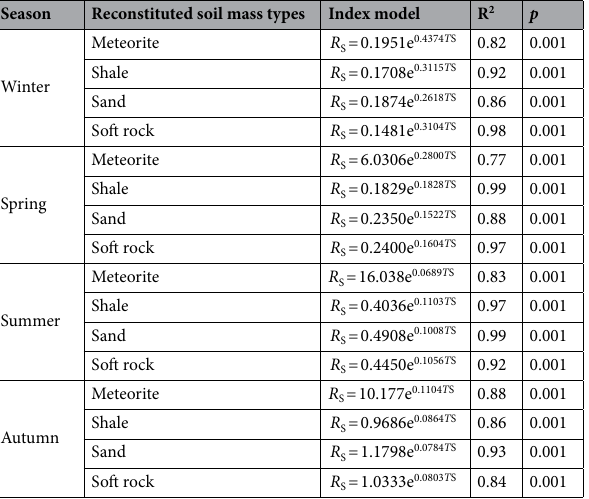
The relationship between respiration and hydrothermal factors of reconstructed soils. The effect of seasonal variation on the relationship between soil respiration and soil temperature. The relationship between soil respiration and soil temperature at 5 cm depth of the four reconstructed soils can be characterised by an exponential model (Table 2). There was a significant positive exponential correlation between respiration rate and temperature of the four reconstructed soils. The soil temperature of meteorite, shale, sand, and soft rock reconstructed soils accounted for 82%, 92%, 86%, and 98% of seasonal variation, respectively, in soil respiration in winter; 77%, 99%, 88%, and 97% of seasonal variation, respectively, in soil respiration in spring; 83%, 97%, 99%, and 92% of seasonal variation, respectively, in soil respiration in summer; and 88%, 86%, 93%, and 84% of seasonal variation, respectively, in soil respiration in autumn. The effect of seasonal variation on the relationship between soil respiration and volumetric water content. The relationship between soil respiration and volumetric water content of the four reconstructed soils can be charac- terised by a quadratic curve model. There was a significant negative correlation between the two, but the ability to interpret was significantly lower than that of temperature (Table 3). Although the changes in soil temperature accounted for most seasonal changes in soil respiration, the temperature effects were not always consistent. Soil respiration was affected by other factors, such as volumetric water content. Thus, volumetric water content at 0–10 cm depth was determined to be the key environmental factor of the soil respiration changes.